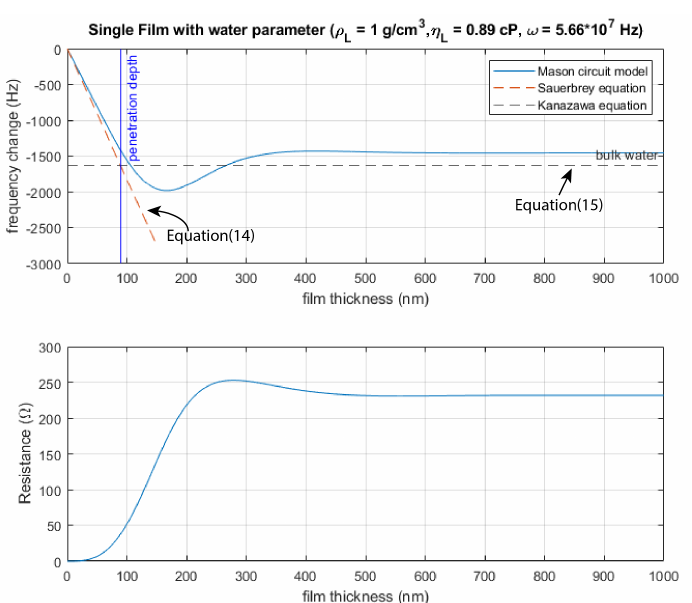
Figure 14. QCM response simulation using Mason equivalent circuit and parameters of